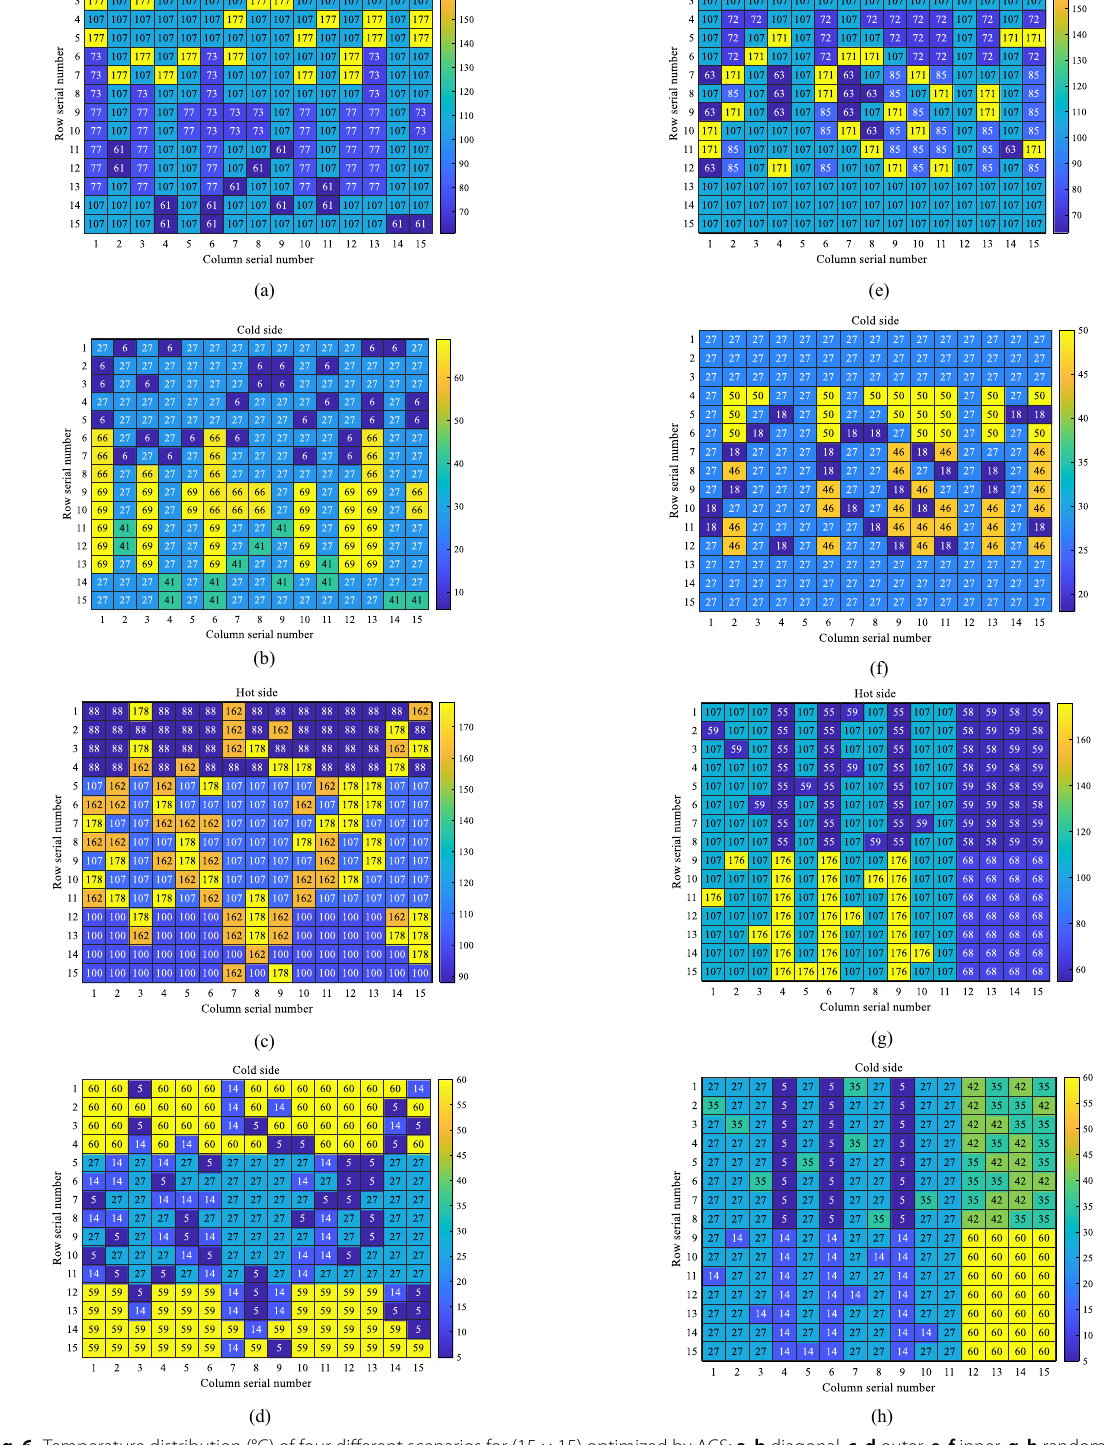
15) optimized by ACS: a , b diagonal, c , d outer, e , f inner, g , h ×